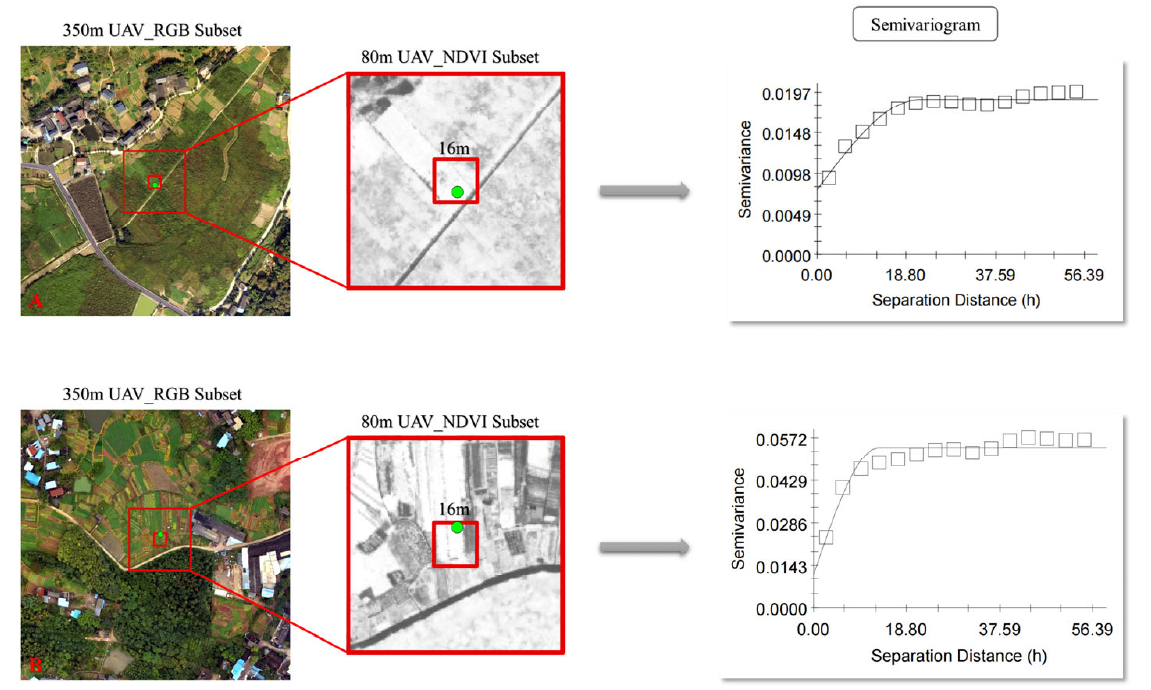
Figure 2. Schematic diagram of the calculation of the semivariogram. ( A ) The window with low spatial heterogeneity. ( B ) The window with high spatial heterogeneity.